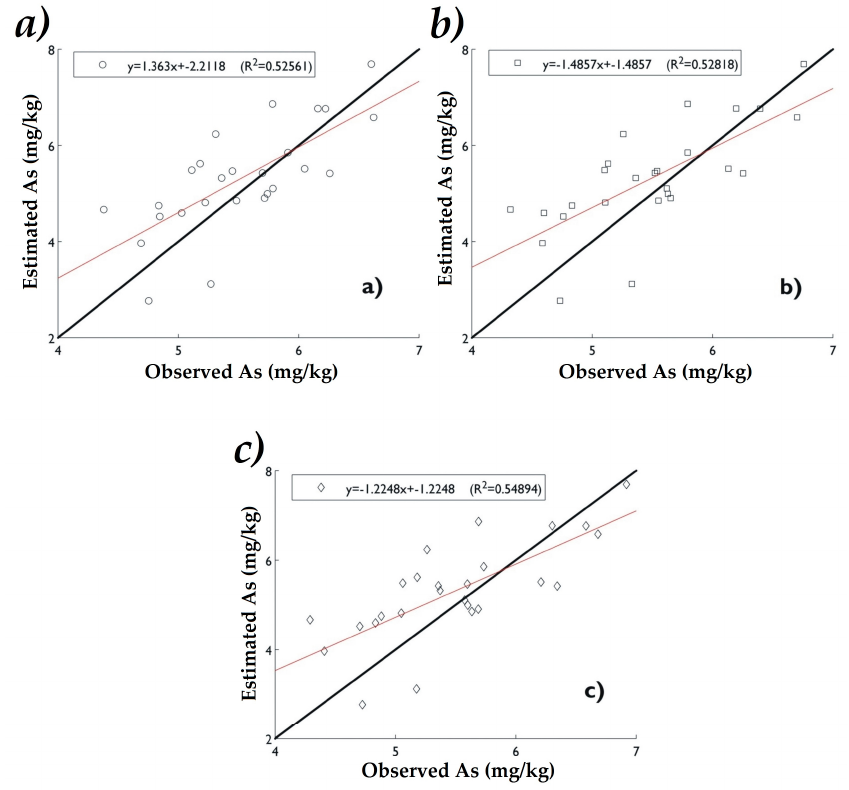
Figure 8. Correlation between experimental and estimated values of As(ln) in P1 by ( a ) IDW, ( b ) OK and ( c ) RBF.